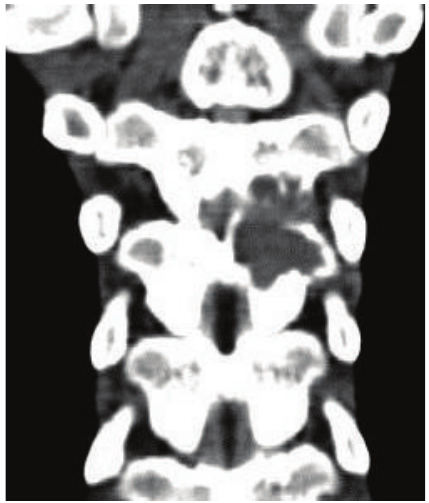
Figure 2: Coronal reformatted CT: eroding areas on the posterior elements of T6 and T7 vertebrae.